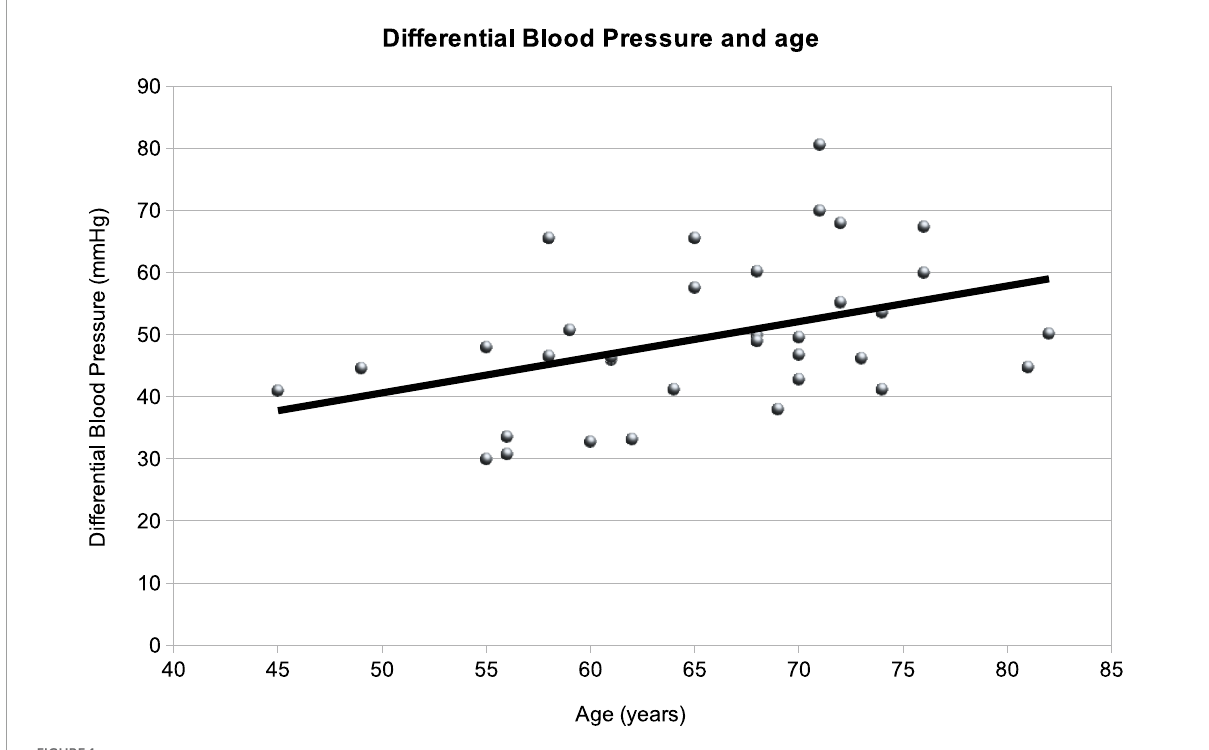
FIGURE1 Graphical representation of the relationship between differential arterial pressure and age. With increasing age also differential arterial pressure increases.